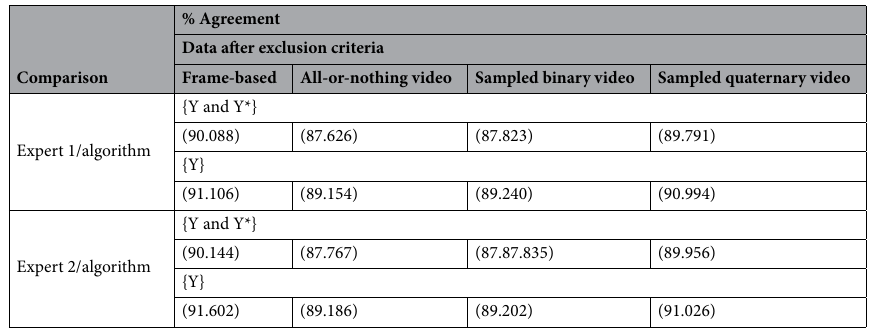
Table 6. Metrics for the inter-observer agreement analysis. (% agreement), {clinical criteria (unhealthy (consolidation/collapse)/healthy dataset) Y: Optimal, Y*: Good, N: Poor}.